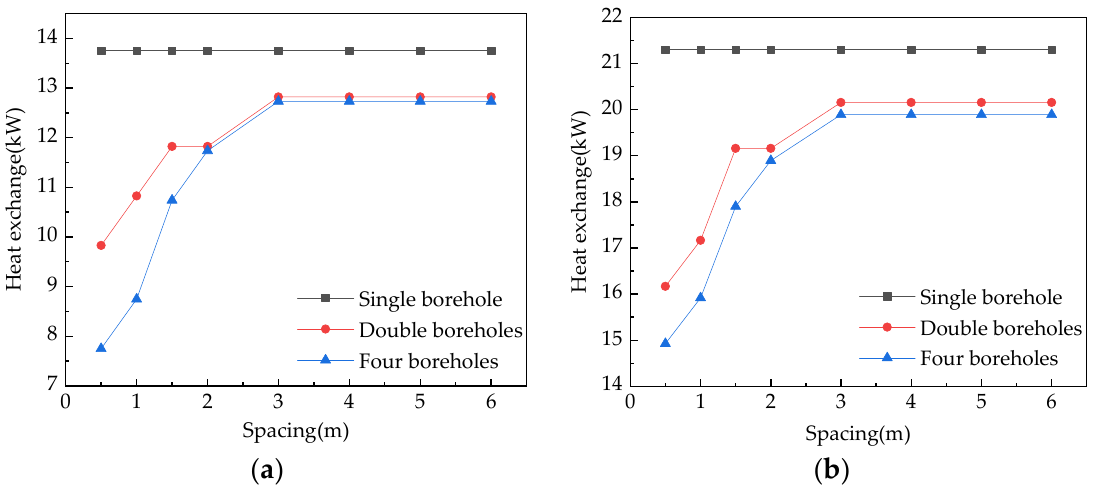
Figure 4. Changes in heat exchange. ( a ) Heat exchange in winter. ( b ) Heat exchange in summer.